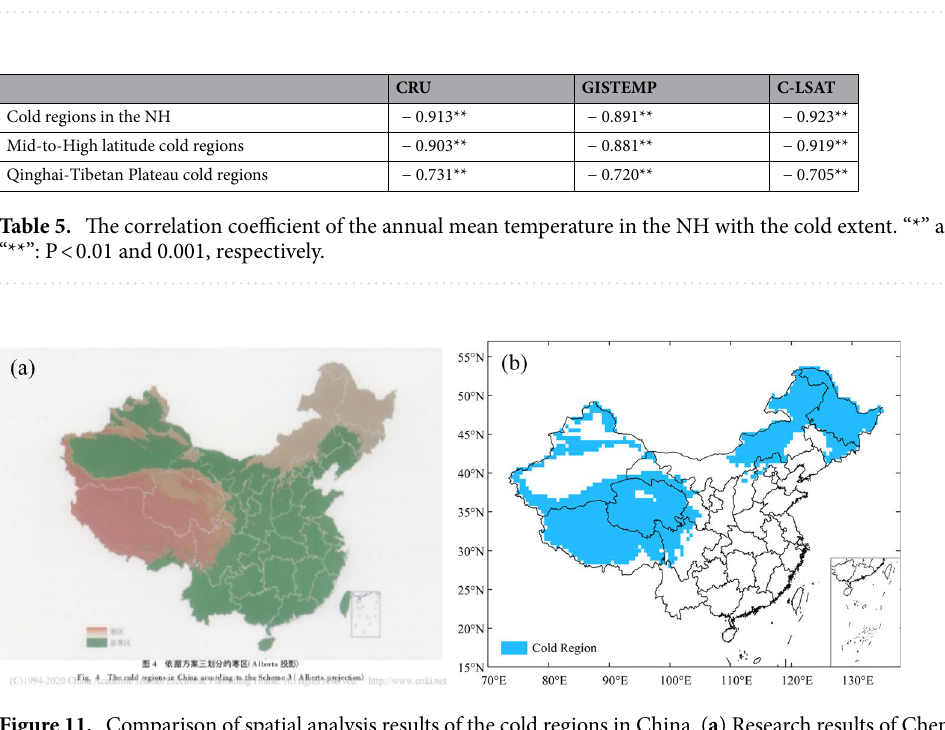
Figure 10. Variations of annual mean temperature in the NH from 1901 to 2019. ( a ) CRUTEM; ( b ) GISTEMP; ( c ) C-LAST2.0.